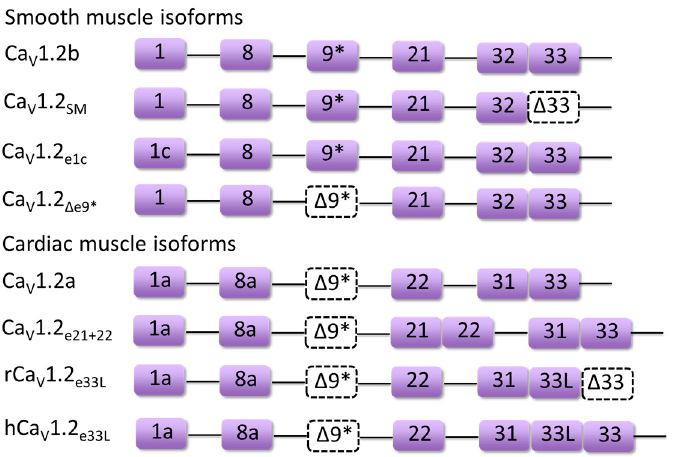
Figure 3. Combinatorial key alternatively spliced exons of major Ca V 1.2 isoforms mentioned in this review such as Ca V 1.2a, Ca V 1.2b, Ca V 1.2 e21+22 are labeled as purple boxes. Dashed boxes indicate